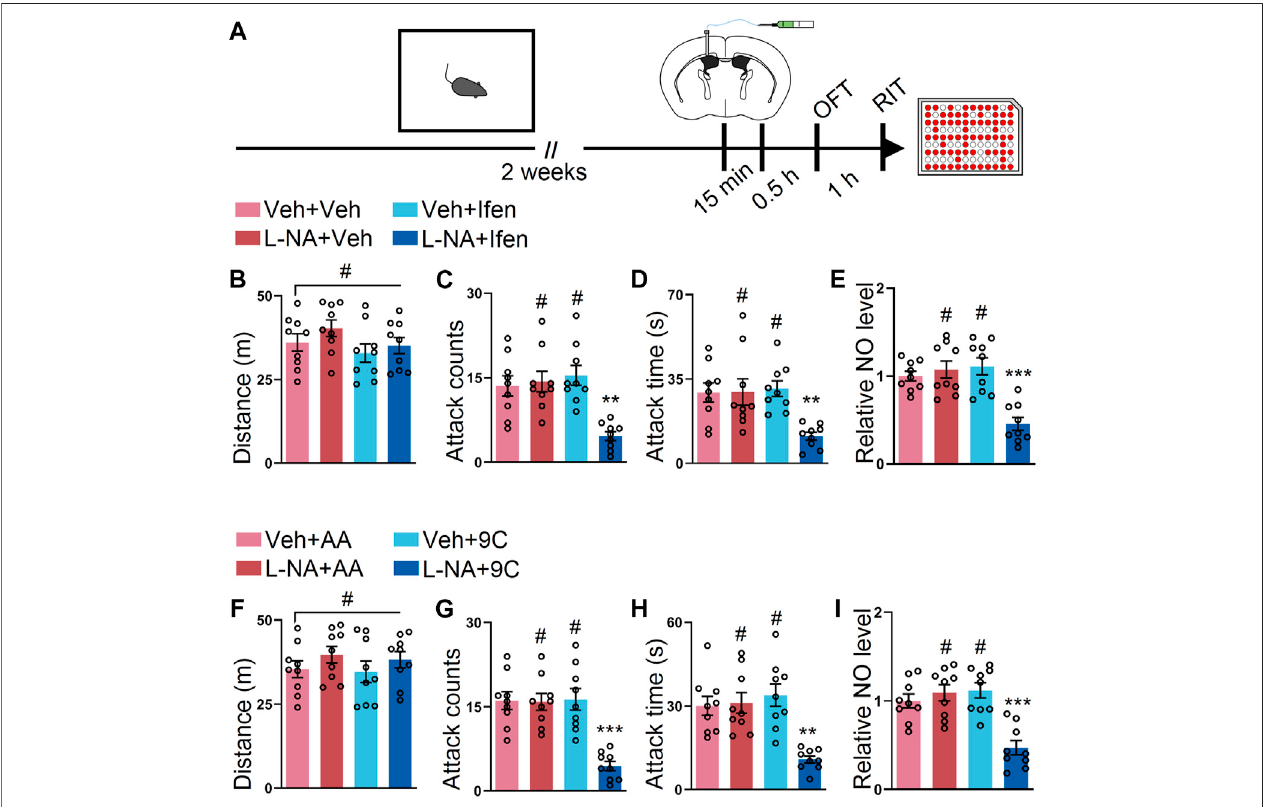
FIGURE 5 | Low dose of L-NAME in combination with ifenprodil or a low dose of L-NAME in combination with TAT-9C corporately reduced the SI-induced heightened attack behavior. (A) Schematic drawing oftheexperimental procedure forbehavioraltests and NOdetection. Themice were implanted with aguidecannula and singly housed for 2 weeks. Afterward, L-NAME (L-NA) and ifenprodil or L-NAME and TAT peptide were injected via the ICV route, and behavioral tests were performed. (B) Total distance of the mice that received L-NAME, ifenprodil, or both during the OFT (F 3, 32 (cid:1) 1.479, p (cid:1) 0.2388). (C) Attack counts of the mice that received L-NAME, ifenprodil, or both during the RIT (F 3, 32 (cid:1) 9.454, p < 0.001). (D) Total attack time of the mice that received L-NAME, ifenprodil, or both during the RIT (F 3,32 (cid:1) 5.988, p (cid:1) 0.0023). (E) TherelativeNOlevelofthecortexfromthemicethatreceivedL-NAME,ifenprodil, orboth (F 3,32 (cid:1) 13.69, p < 0.001). (F) Totaldistanceof the mice thatreceived L-NAME,TATpeptide,orboth during theOFT (F 3,32 (cid:1) 0.8068, p (cid:1) 0.4994). (G) Attack countsofthemice thatreceivedL-NAME,TATpeptide,or both during the RIT(F 3,32 (cid:1) 14.91, p < 0.001). (H) Total attack timeofthe mice thatreceived L-NAME, TATpeptide,or both during theRIT(F 3,32 (cid:1) 10.24, p < 0.001). (I)